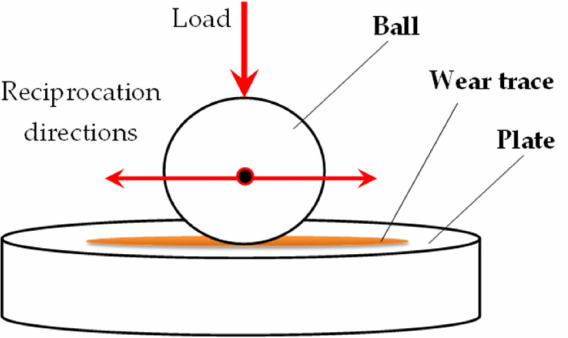
Figure 5. Schematic view of the ball-on-plate tribo-test used in this